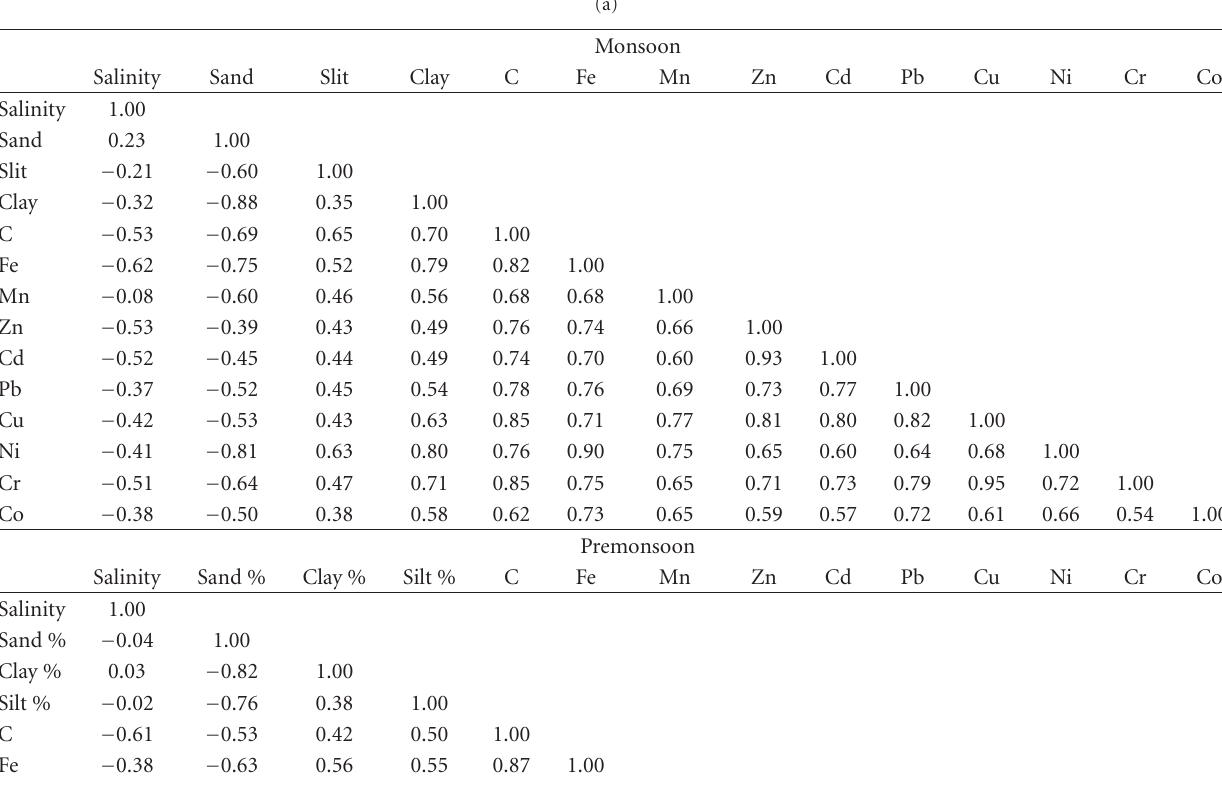
Table 2: (a) Correlation analysis of di ff erent parameters during monsoon and premonsoon (zone 1). (b) Correlation analysis of di ff erent parameters during monsoon and premonsoon (zone 2). (c) Correlation analysis of di ff erent parameters during monsoon and premonsoon (zone